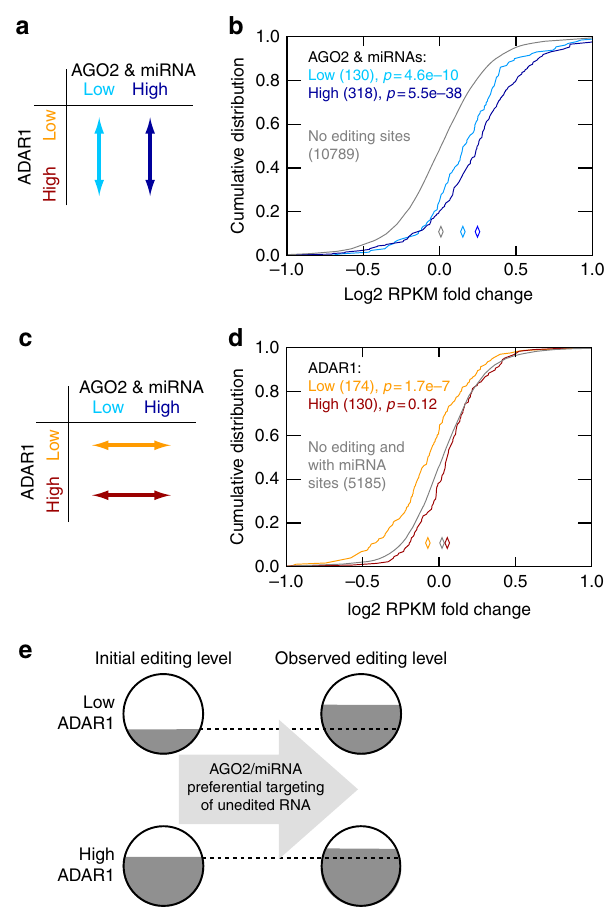
Fig. 5 AGO2-miRNA preferentially targets unedited RNA for degradation. a Illustration of the comparisons shown in b . b Comparison of target gene expression levels between individuals with low and high ADAR1 expression levels. X -axis shows log2 fold change of gene expression levels (target genes grouped by ADAR1 level: high/low). The data were further separated into three categories consisting of individuals with similarly low or high AGO2 and miRNA expression levels (and requiring miRNA target sites and editing sites to be within 500 nt), and those with no editing sites in these genes. The number of gene-miRNA combinations included in each group is shown in parenthesis. Diamonds represent the medians of the respective curves. P values are shown for comparisons against the “ no-editing ” group (Wilcoxon Rank-Sum test). c Illustration of the comparisons shown in d . d Same as b , but for different groups of individuals as illustrated. X -axis shows log2 fold change of gene expression levels (target genes grouped by AGO2 & miRNA levels: high/low). e The impact of AGO2-miRNA targeting on observed RNA editing levels according to the following model: AGO2-miRNA preferentially targets unedited version of the transcripts and has more pronounced impact on sites with low initial editing level (upper) than those with high initial editing level (lower). Thus, the